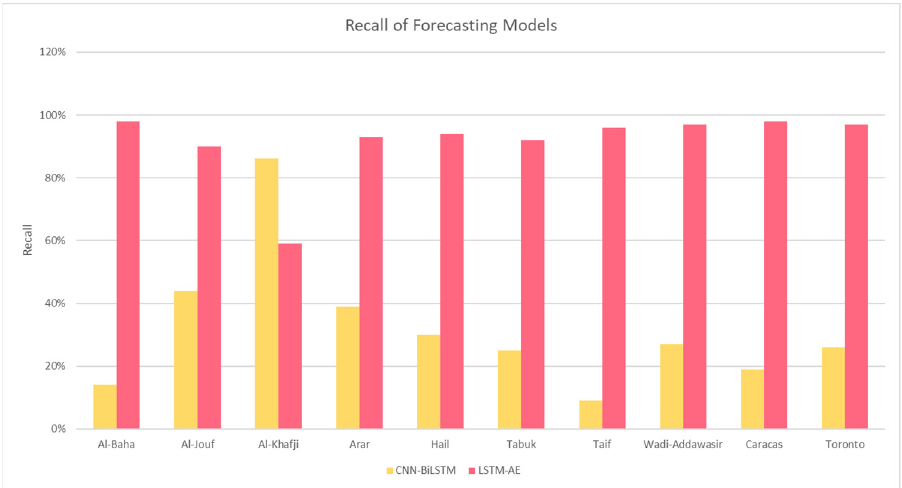
Figure 35. Recall of the two forecasting models in model prediction engine.